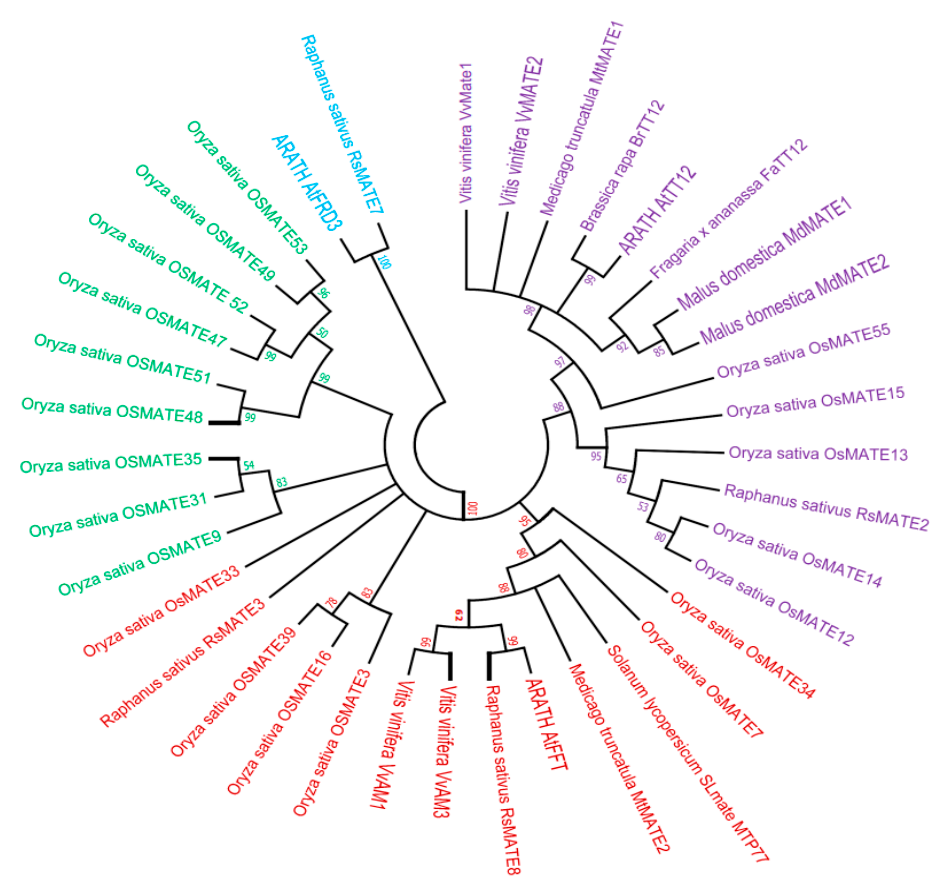
Figure 2. Molecular phylogenetic tree of OsMATEs proteins. Each color represents one cluster (CL): cluster1 (CL1), blue color; cluster2 (CL2), green color; cluster3 (CL3), red color; cluster4 (CL4), violet color.